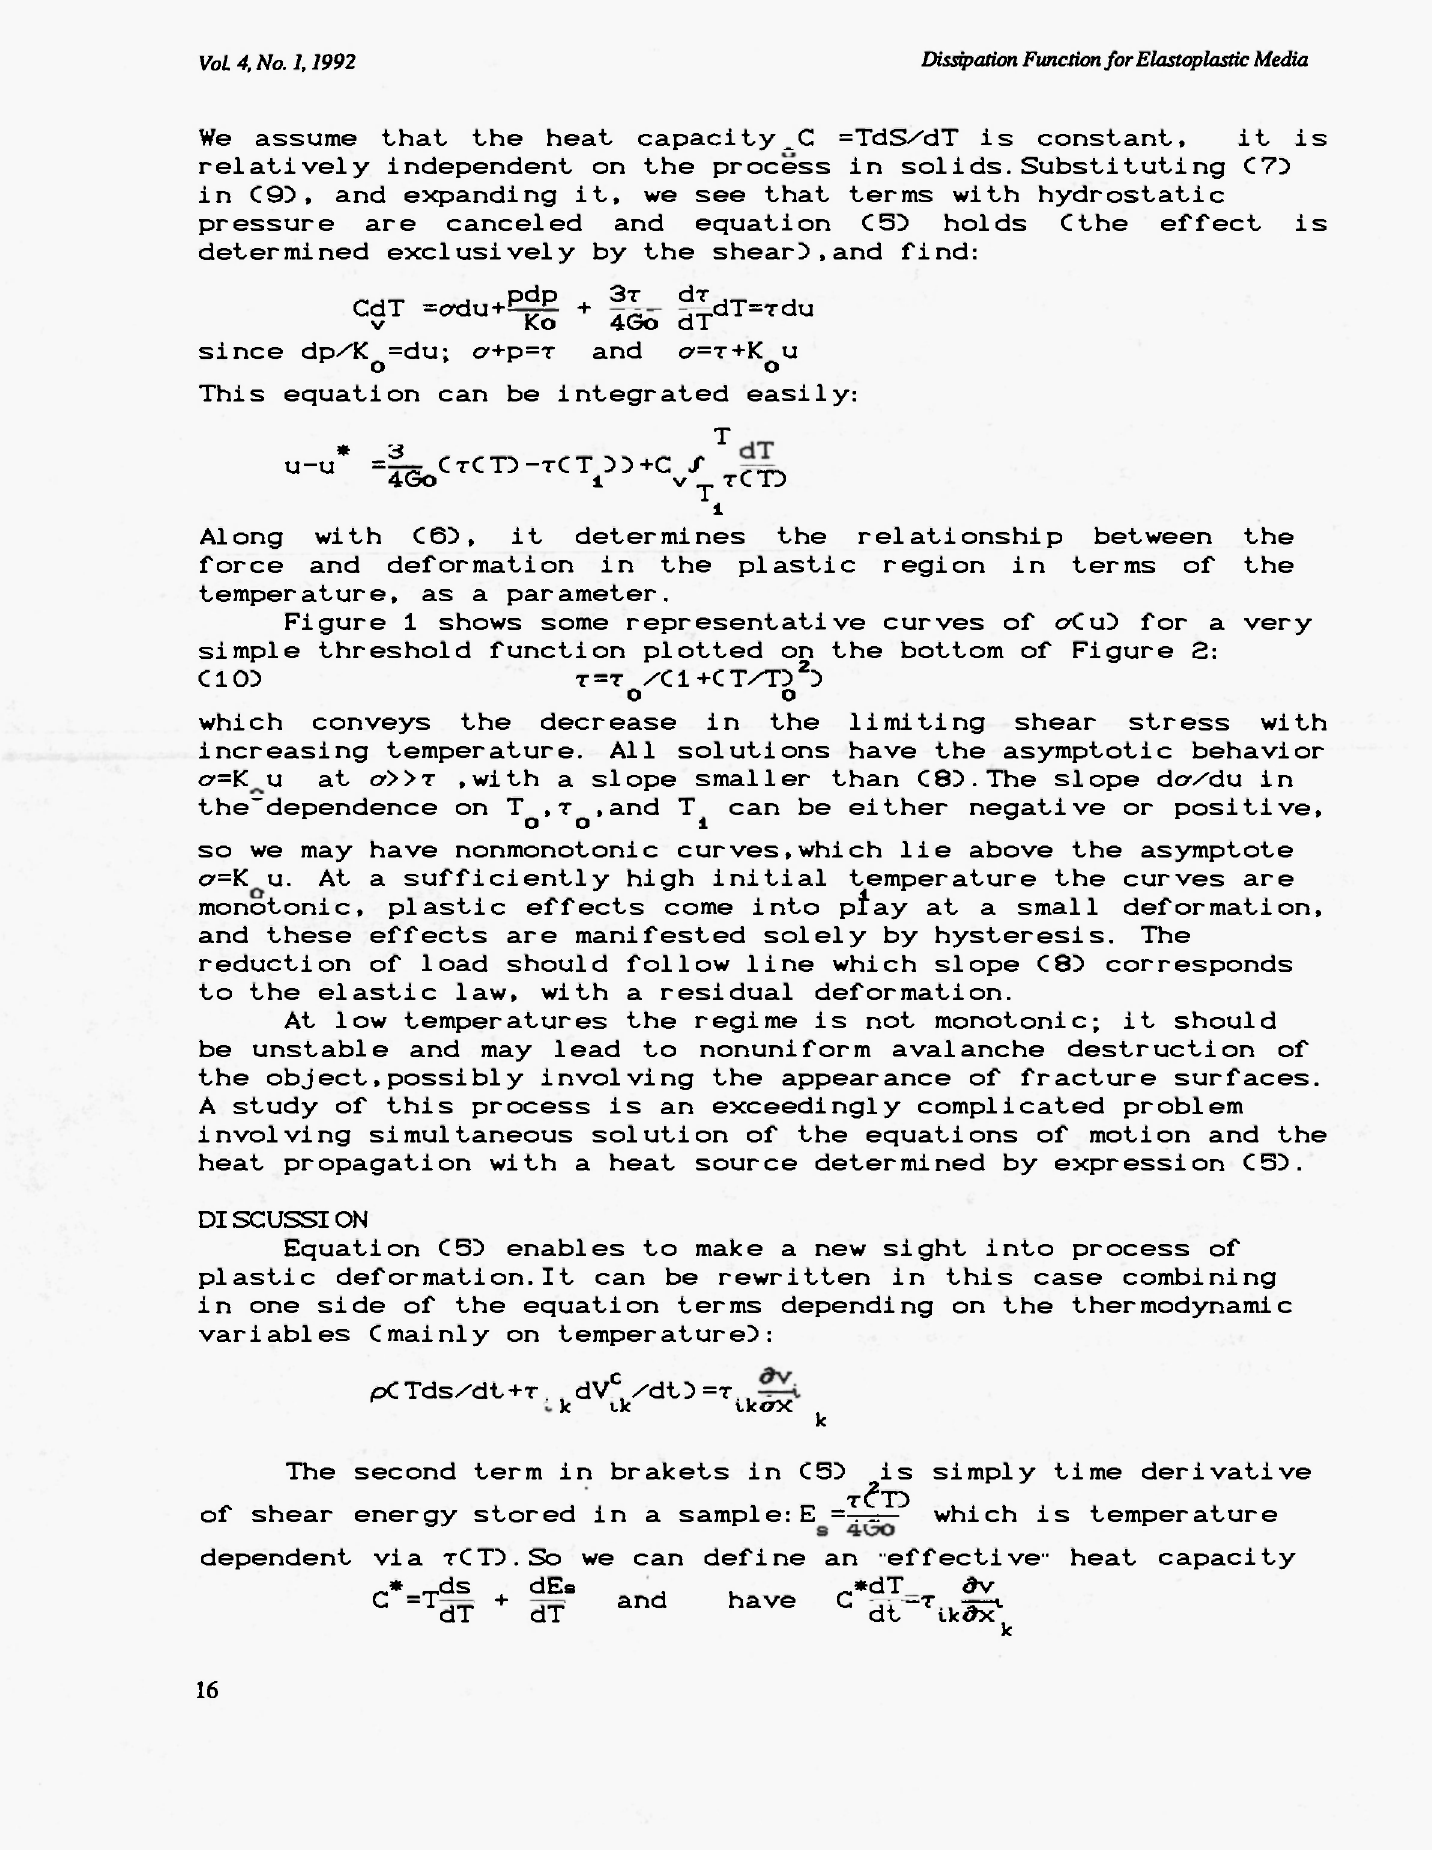
Figure 1 shows some r e p r e s e n t a t i ve curves of cCuD f or a